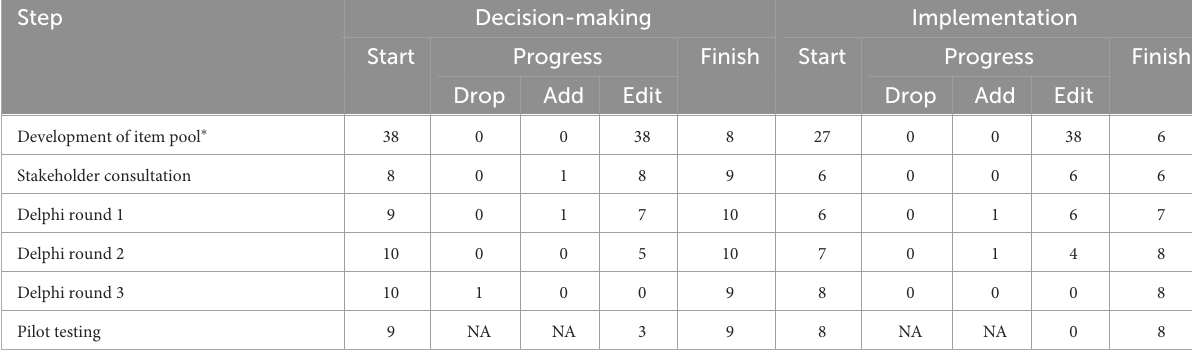
TABLE 1 Changes in the number of items during the item generation process of the country score tool. Step Decision-making